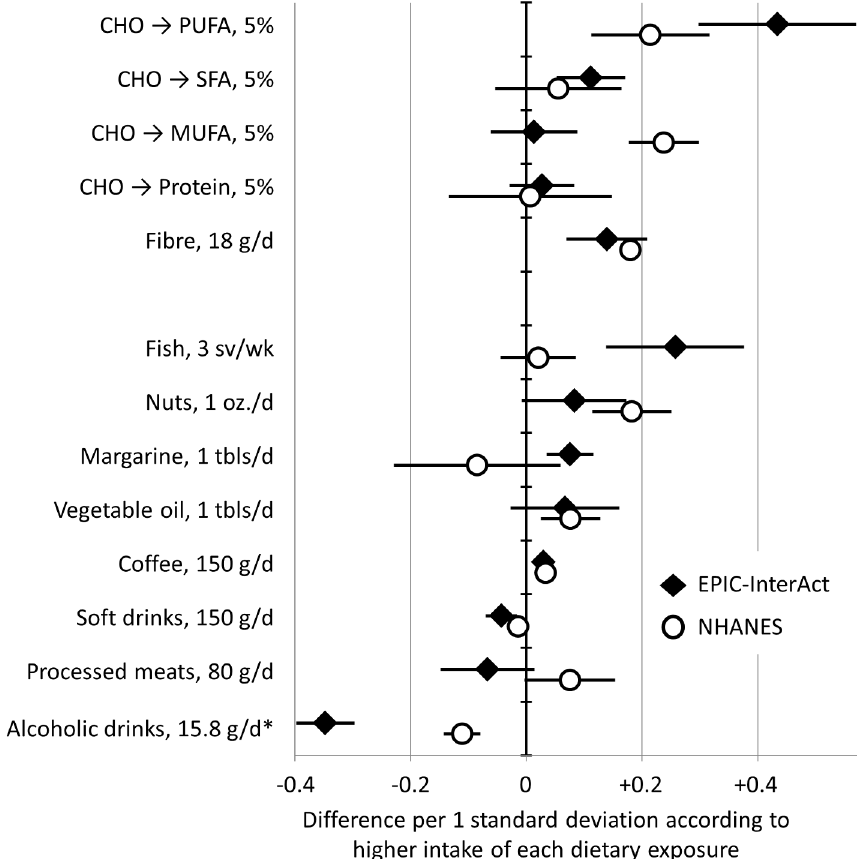
Fig 3. Associations of dietary factors with the fatty acid pattern score in EPIC-InterAct (1991–1998, n = 15,566) and the US National Health and Nutrition Examination Survey (2003–2004, n = 1,500). Error bars are 95% confidenceintervals. In analysisfor macronutrients, analysisestimated potential effects of replacingcarbohydrate (CHO) intakes with intakes of polyunsaturated fatty acid (PUFA), monounsaturated fatty acid (MUFA), saturatedfatty acid (SFA), and protein by the amount of 5% of total caloric intake. Dietary factors were scaled for interpretability: sv, serving; oz., ounce(28.8 g); tbls, tablespoon. * Alcoholic drinks were examinedas grams of